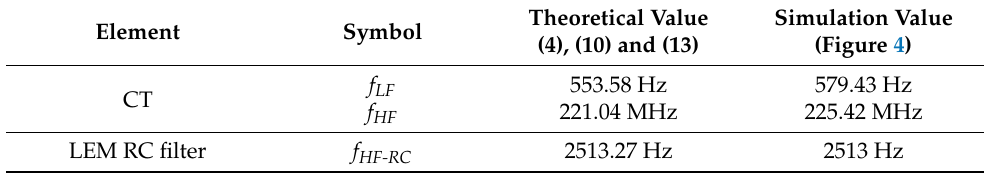
Figure 5. ALCS sensor output voltage (V) in the function of the measured current (A). The differ- ence between the theoretical and the practical chart does not exceed 0.03 V.